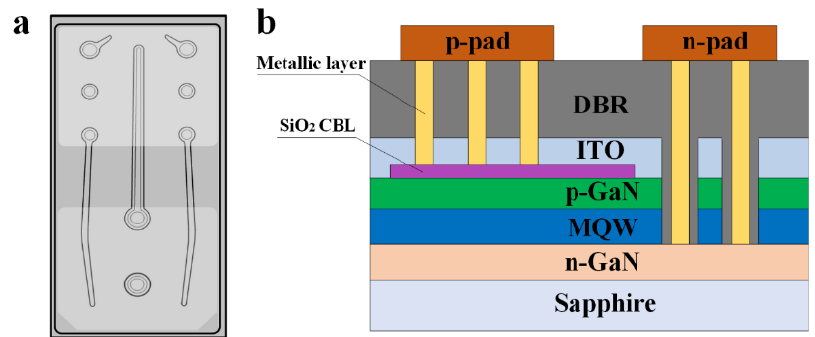
Figure 2. Schematic illustration of a FCLED with DBR: ( a ) Top-view image. ( b ) Cross-section image.